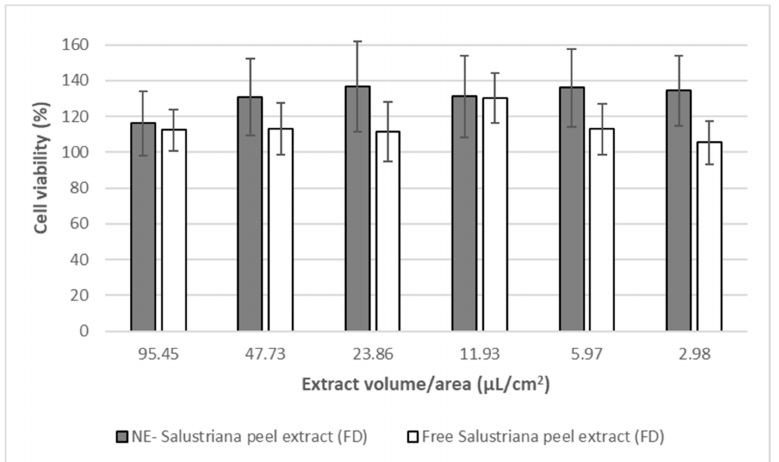
Figure 7. Effect of nanoemulsion (NE) on the cell viability of Caco-2, in comparison with the pressurized free extract. Free Salustriana peel extract freeze-dried, previously freeze-dried (FD). NE-Salustriana peel extract freeze-dried, previously freezedried